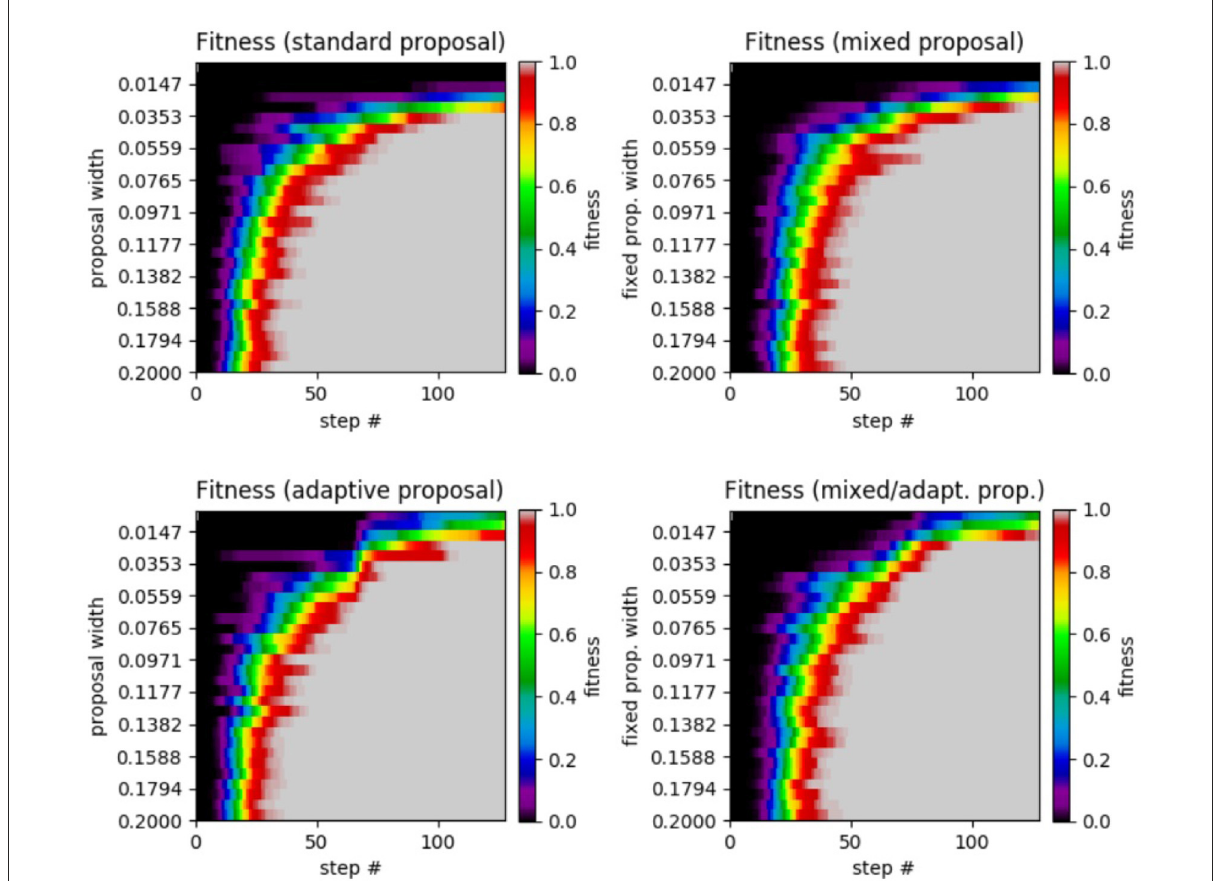
FIGURE7 Results of GA test on the α − pinene application. (Top left) Standard GA. (Top right) Mixed GA. (Bottom left) Adaptive GA. (Bottom right) Mixed/adaptive GA. The horizontal axis displays the step number while the vertical axis represents the the proposal width (increases downward). The color axis displays the average fitness across the 25 runs of each method.